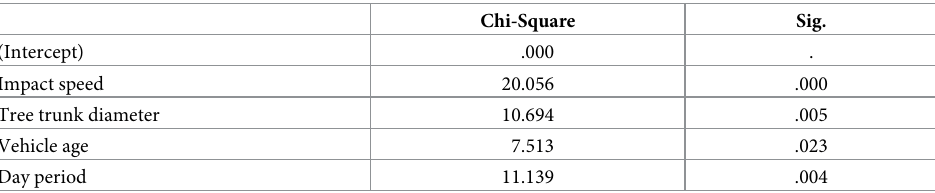
Table 4. Likelihood ratio